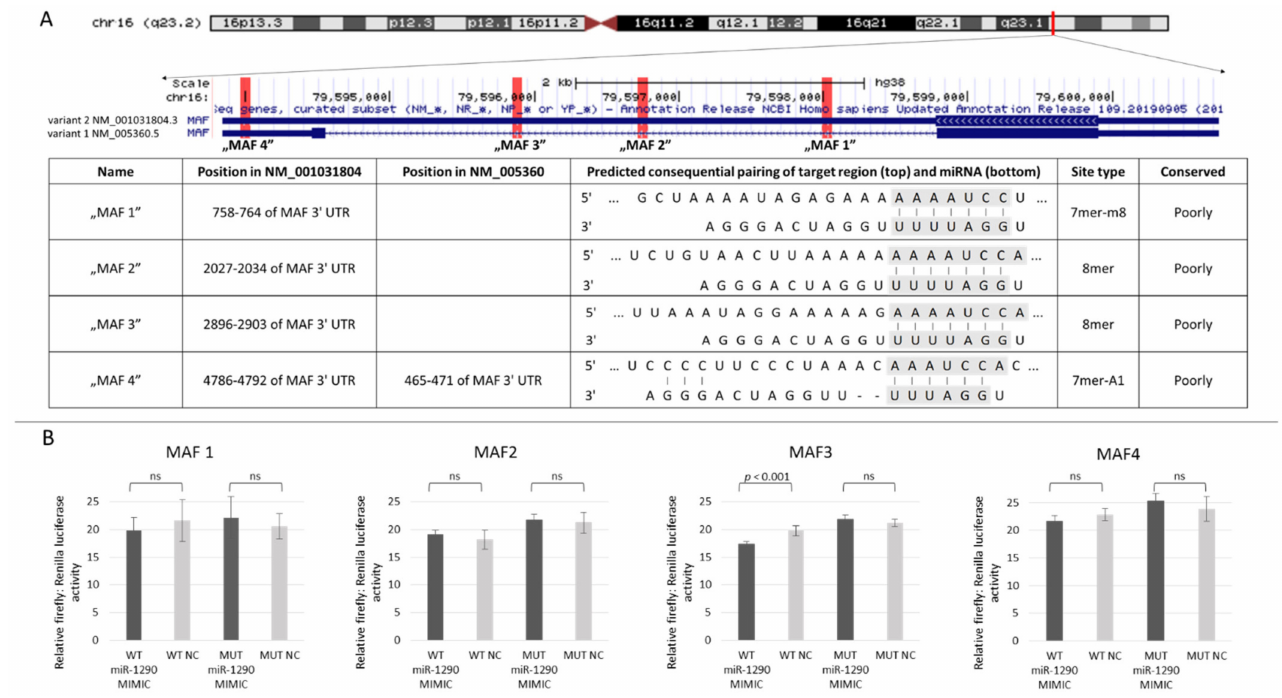
Figure 1. Characterization of has-miR-1290 binding sites in the 3 (cid:48) UTR of MAF ( A ). Luciferase reporter assay results for four hsa-miR-1290 binding sites in the MAF 3 (cid:48) UTR (ns = not significant) ( B